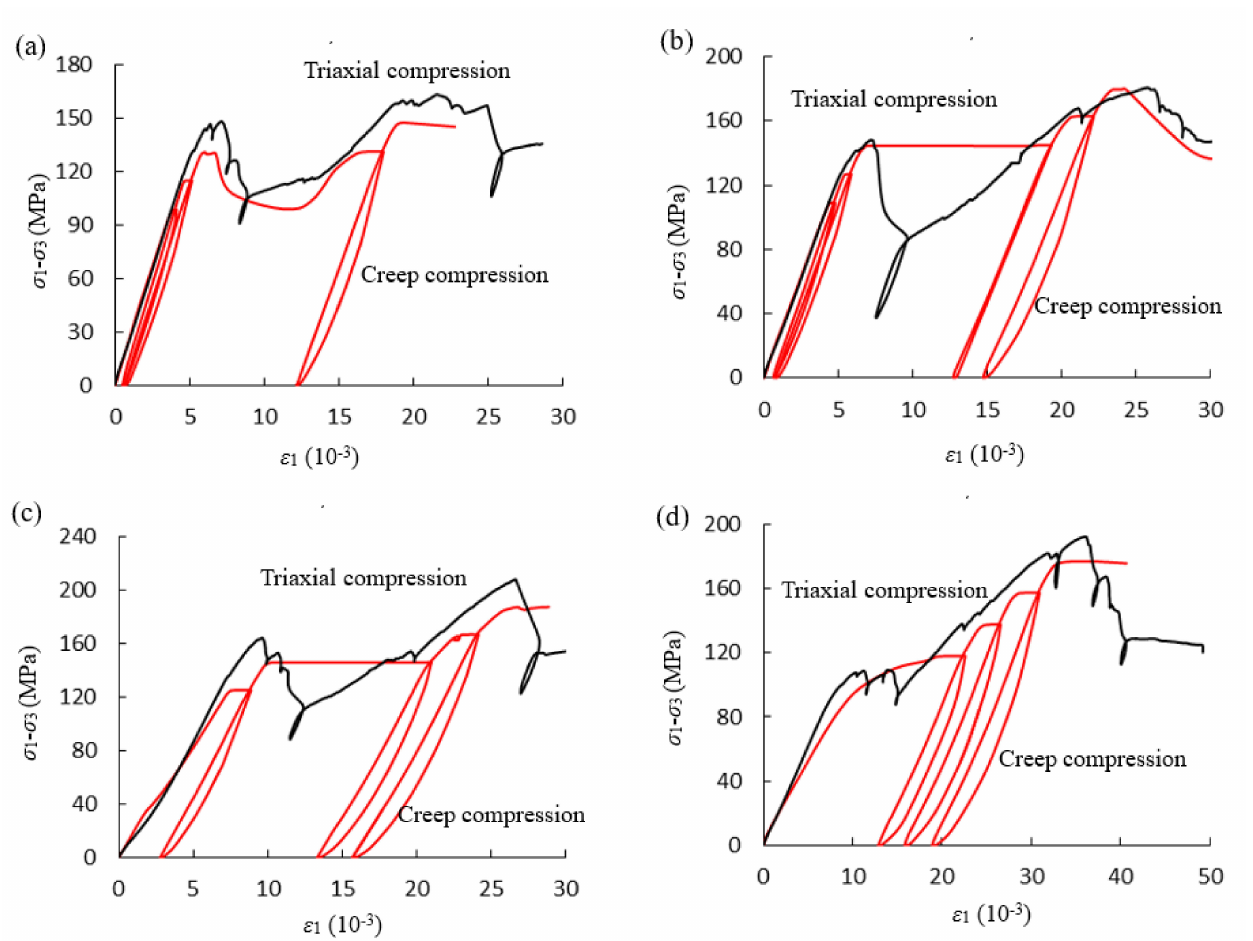
Figure 4. Axial stress-strain curves of pre-cracked sandstone under different loading paths. ( a ) T = 250 ◦ C, ( b ) T = 500 ◦ C, ( c ) T = 750 ◦ C, ( d ) T = 1000 ◦